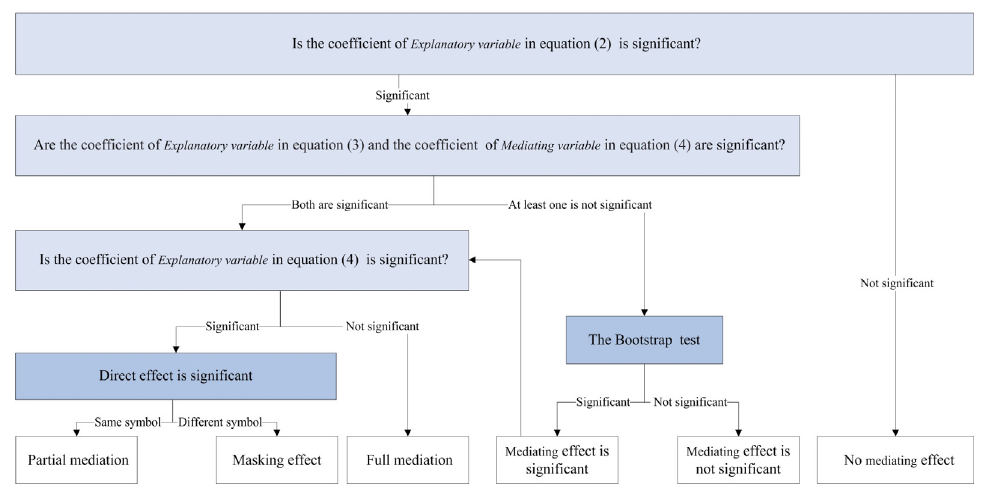
Figure 3. Steps for the mediating effect